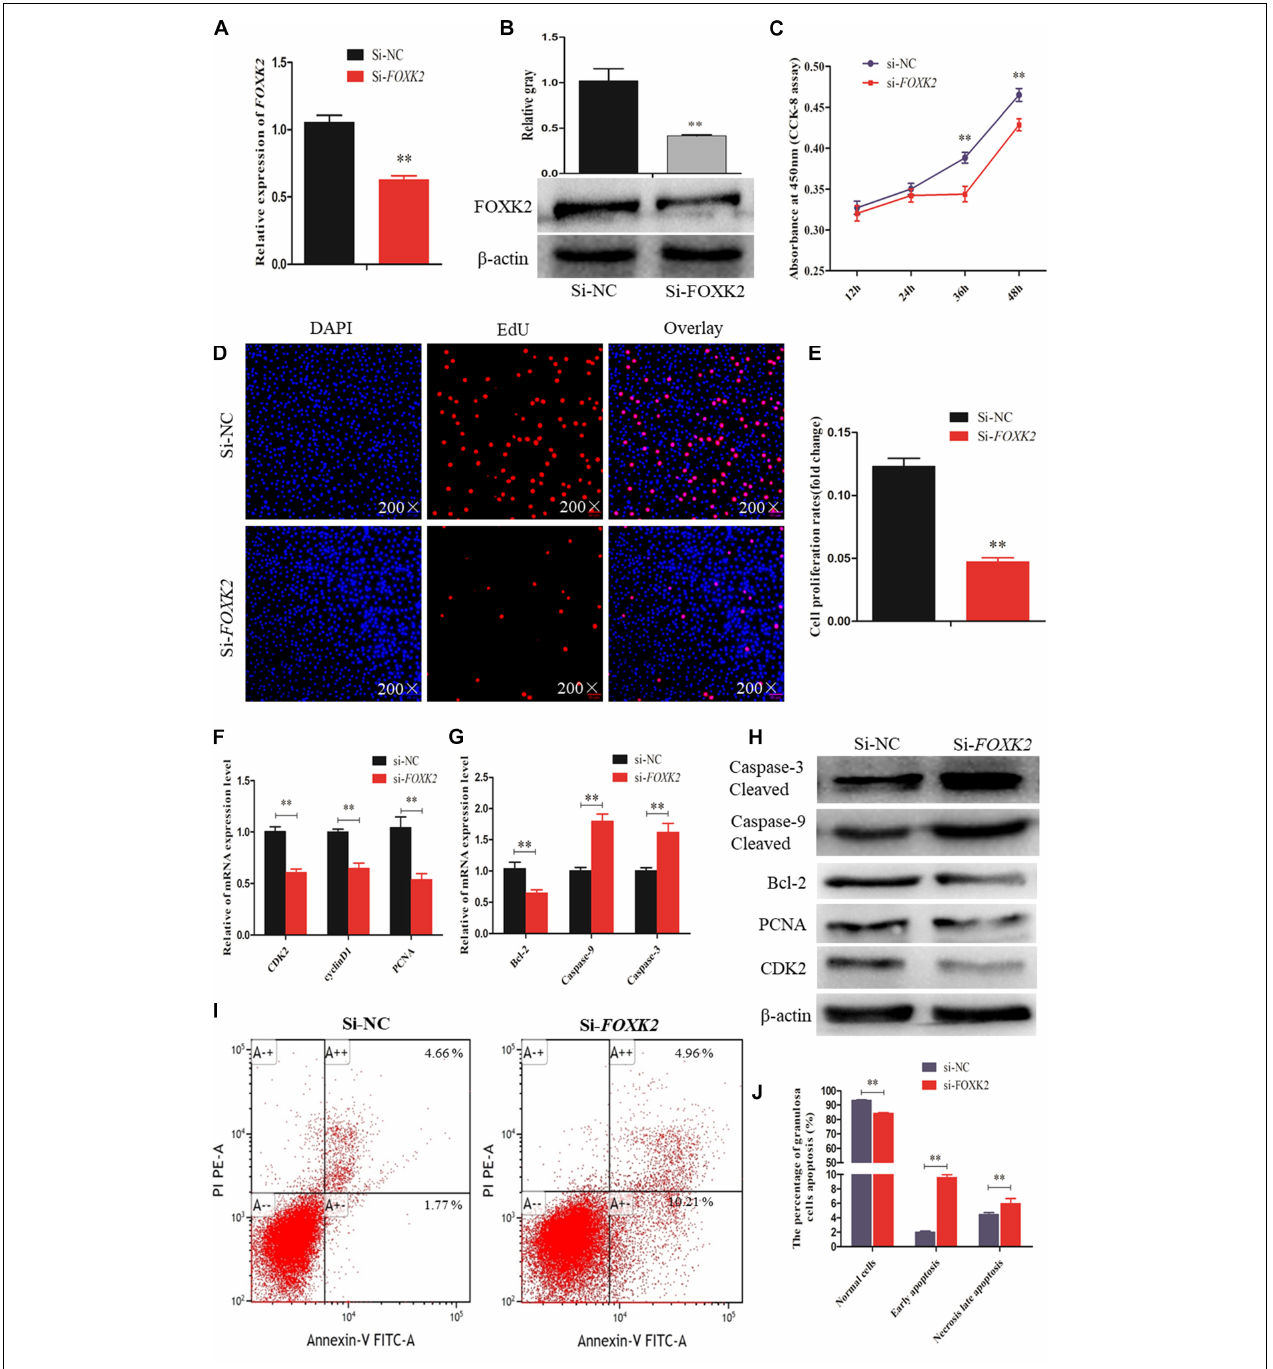
FIGURE 5 | Forkhead box K2 (FOXK2) regulates chicken granulosa cell (GC) proliferation and apoptosis. (A, B) The mRNA and protein expressions of FOXK2 were detected after transfection of Si-FOXK2, respectively. (C) Cell proliferation status was detected at 450 nm with cell counting kit-8 (CCK-8) reagent after silencing FOXK2. (D, E) 5-Ethynyl-2-deoxyuridine (EdU) staining-positive GCs were detected by EdU kit after downregulation of FOXK2. (F) The mRNA expression levels of cell proliferation-related genes ( PCNA , CDK2 , and cyclinD1 ) were detected by quantitative real-time PCR (qRT-PCR) after FOXK2 knockdown. (G) The mRNA expressions of cell apoptosis-related genes ( Bcl-2 , Caspase-9 , and Caspase-3 ) were detected by qRT-PCR after downregulation of FOXK2. (H) The protein expression levels of cell proliferation-related genes (CDK2 and PCNA) and cell apoptosis-related gene (Bcl-2, Caspase-9, and Caspase-3) were detected by Western blot analysis after FOXK2 knockdown. (I, J) Apoptotic GCs were detected by annexin V-fluorescein isothiocyanate (FITC)/propidium iodide (PI) staining flow cytometry following FOXK2 silencing. Replications = 3. Data are presented as mean ± SE; Si, small RNA interference. * P < 0.05 and ** P < 0.01.